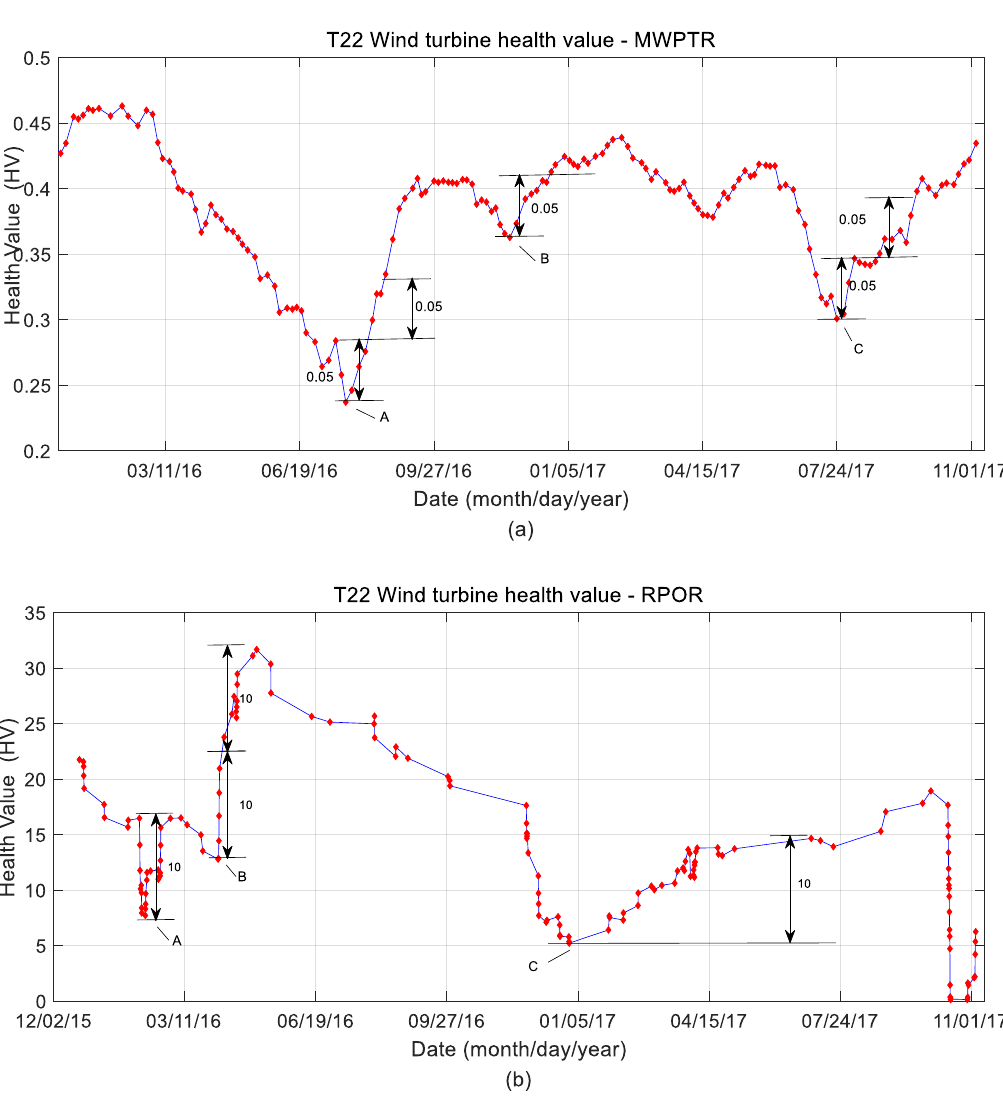
Figure 15. Early warning for wind turbines based on health value curve ( a ) Health value curves of T22 wind turbine in the MWPTR with the PAM method; ( b ) Health value curves of T22 wind turbine in the PROR with the PAM method.